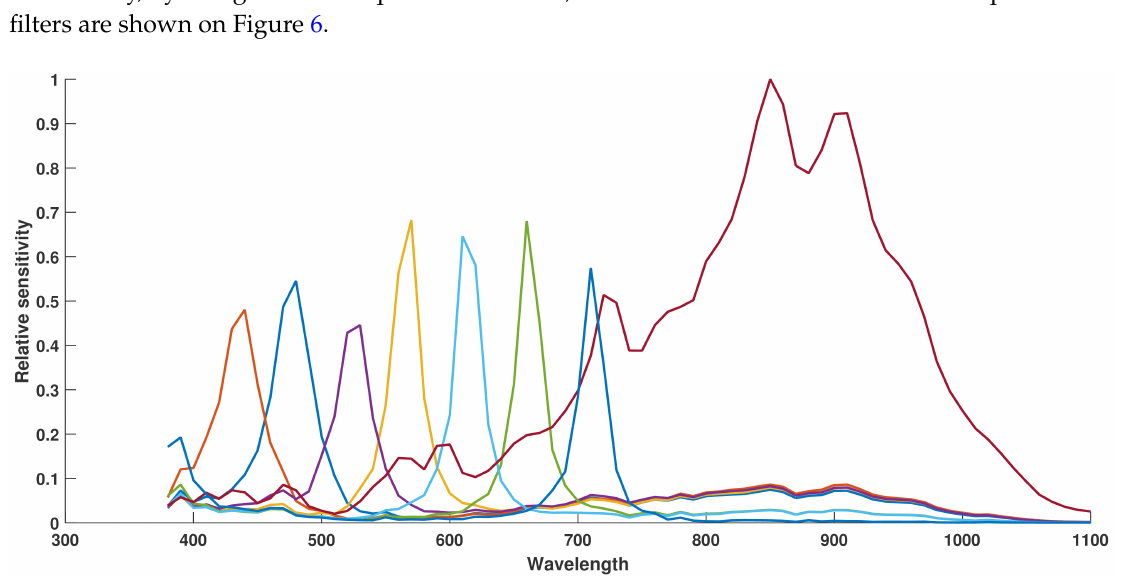
Figure 6. The actual SFA MSI system relative spectral sensitivities after pre-processing, as described in Section 3.1. This is the measure of the relative efficiencies of each channel, and no simulation is added. Curves data are provided as Supplementary Materials in file Excel